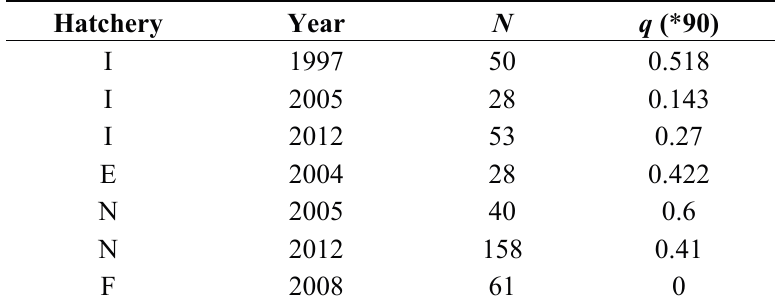
Table 1. Frequency of the allele LDH-C1*90, as q (*90), in the broodstocks of four hatcheries that carry out juvenile brown trout releases in the High Narcea in different years. N , sample size.